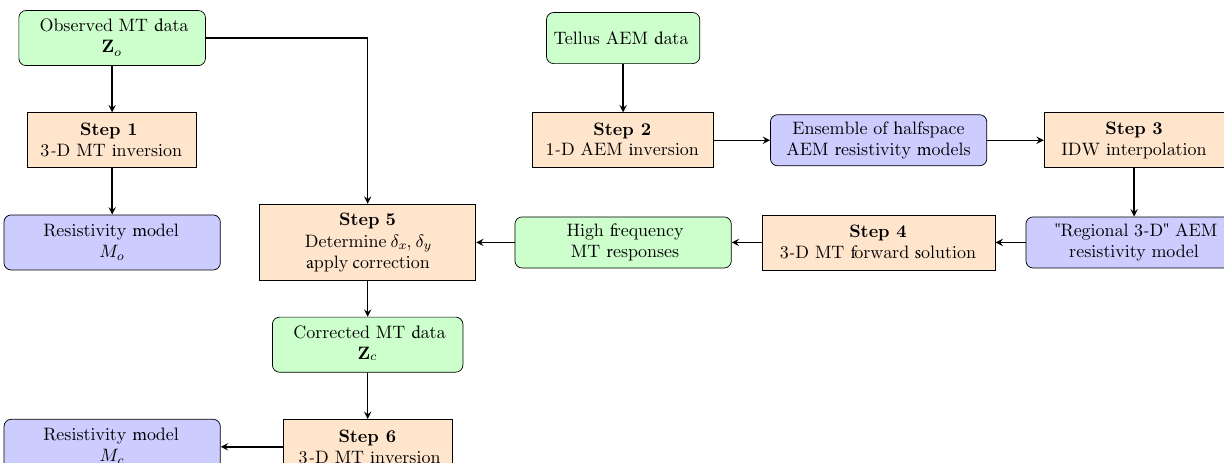
Figure 5. Flowchart illustrating the steps required to (a) find an original, uncorrected resistivity model M o from MT data (Step 1 only) and (b) find an improved, static-shift-corrected resistivity model M c from MT data, with coincident airborne FDEM data (data from the Tellus project used for this study). For clarification, the MT data used in Step 5 are in their original coordinate system, whereas the MT data in Steps 1 and 6 are rotated to a bearing of 315 ◦ for inversion. IDW in Step 3 refers to inverse distance weighting.